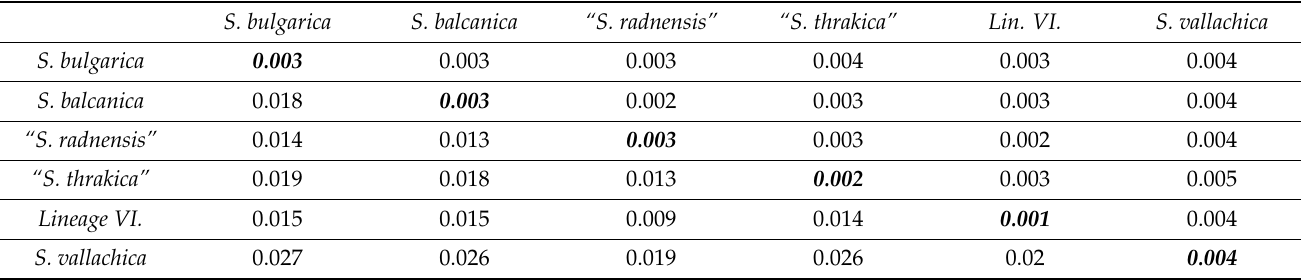
Table 4. Genetic divergences (by the TN93 model) on cyt b sequences between the molecularly studied Sabanejewia species. (The number of base differences per site from averaging over all sequence pairs between groups are shown; standard error estimate(s) are shown above the diagonal. Distances within groups are shown diagonally in bold).